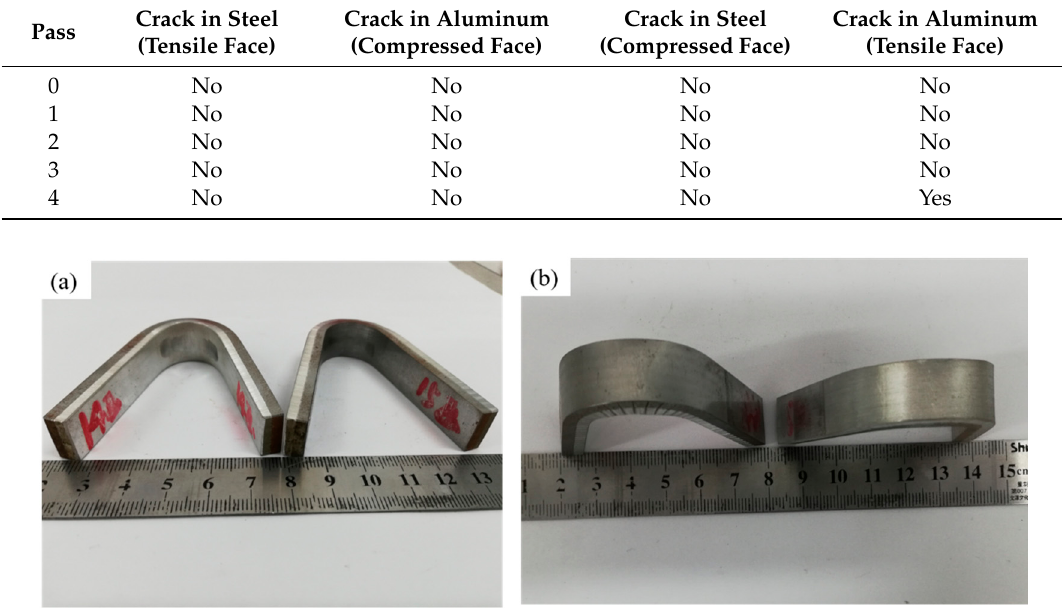
Table 4. Results of bending test of composite plate.